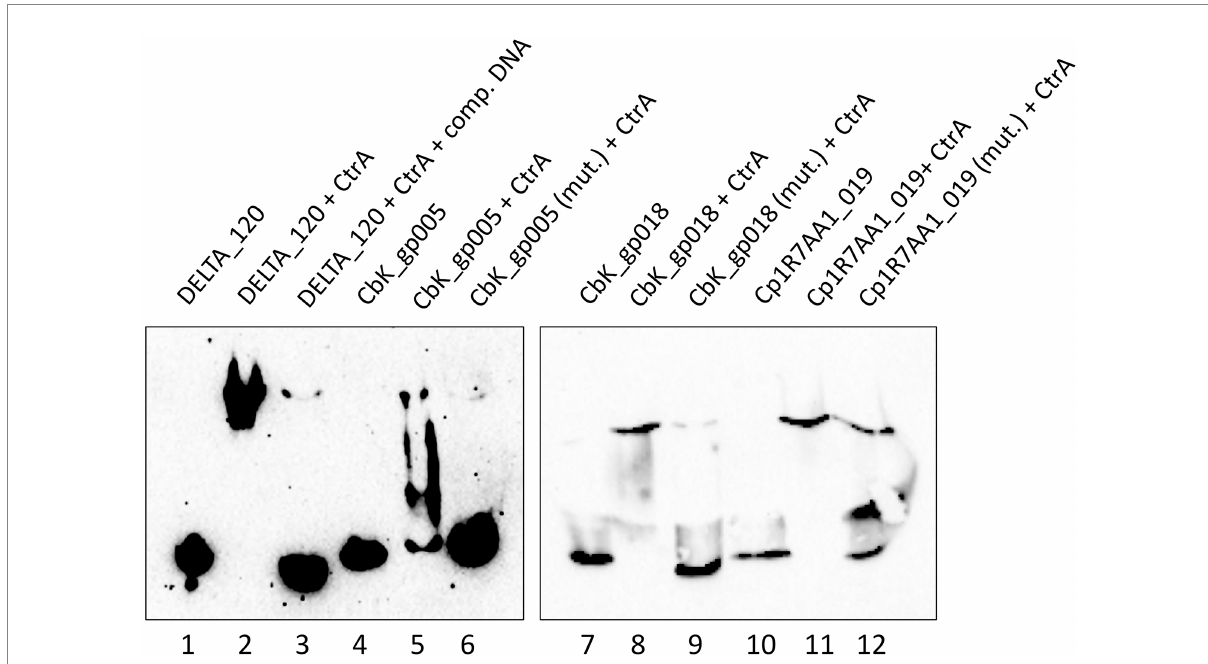
FIGURE 10 CtrA binds to LPEG phage DNA containing predicted CtrA-binding sites. EMSA assays using purified C. crescentus CtrA protein and DNA probes from different LPEG phages. Lane 1: Brevundimonas phage vB_BsubS-Delta DELTA_120 DNA. Lane 2: DELTA_120 DNA with phosphorylated CtrA. Lane 3: DELTA_120 DNA with phosphorylated CtrA and unlabeled DELTA_120 competitor DNA at 100-fold molar excess. Lane 4: Caulobacter phage Φ Cbk CbK_gp005 DNA. Lane 5: CbK_gp005 DNA with phosphorylated CtrA. Lane 6: CbK_gp005 DNA with mutated CtrA binding site, with phosphorylated CtrA. Lane 7: Caulobacter phage Φ Cbk CbK_gp018 DNA. Lane 8: CbK_gp018 DNA with phosphorylated CtrA. Lane 9: CbK_gp018 with mutated CtrA binding site, with phosphorylated CtrA. Lane 10: Mesorhizobium phage Cp1R7A-A1 Cp1R7AA1_019 DNA. Lane 11: Cp1R7AA1_019 DNA with phosphorylated CtrA. Lane 12: Cp1R7AA1_019 DNA with mutated primary CtrA binding site, with phosphorylated